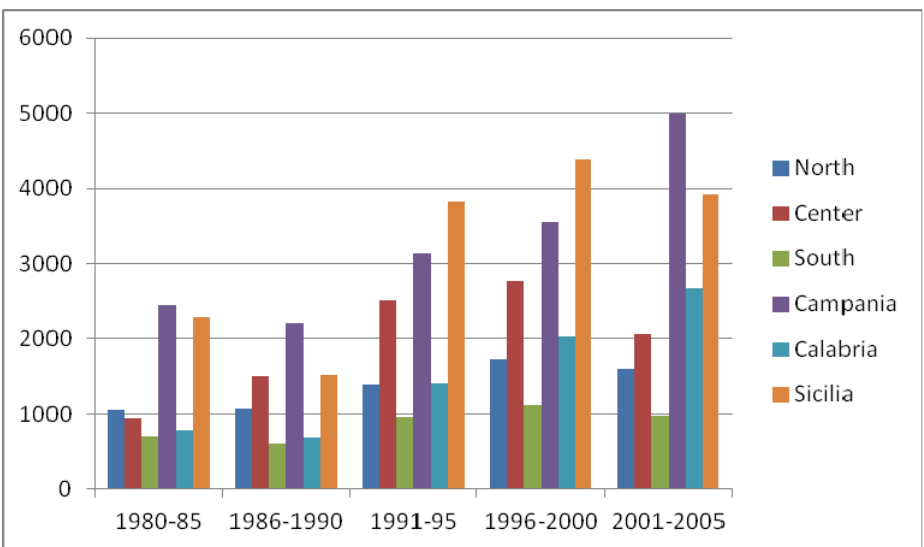
Figure 3. Corruption crimes (average annual